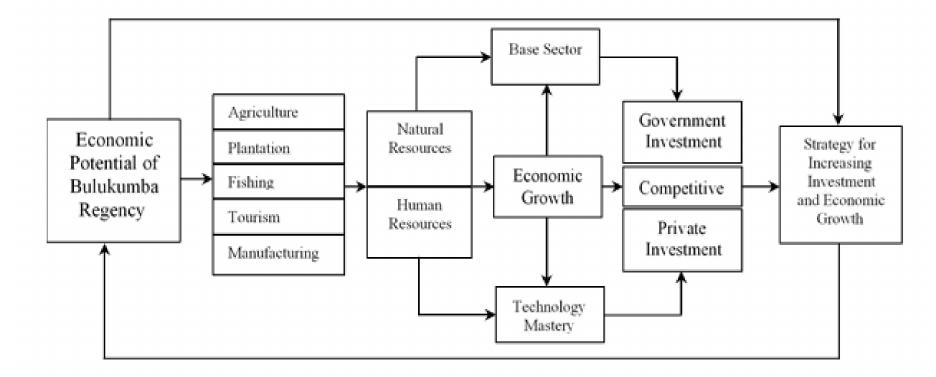
Figure 1. Conceptual Framework for Economic Growth in Bulukumba Regency.